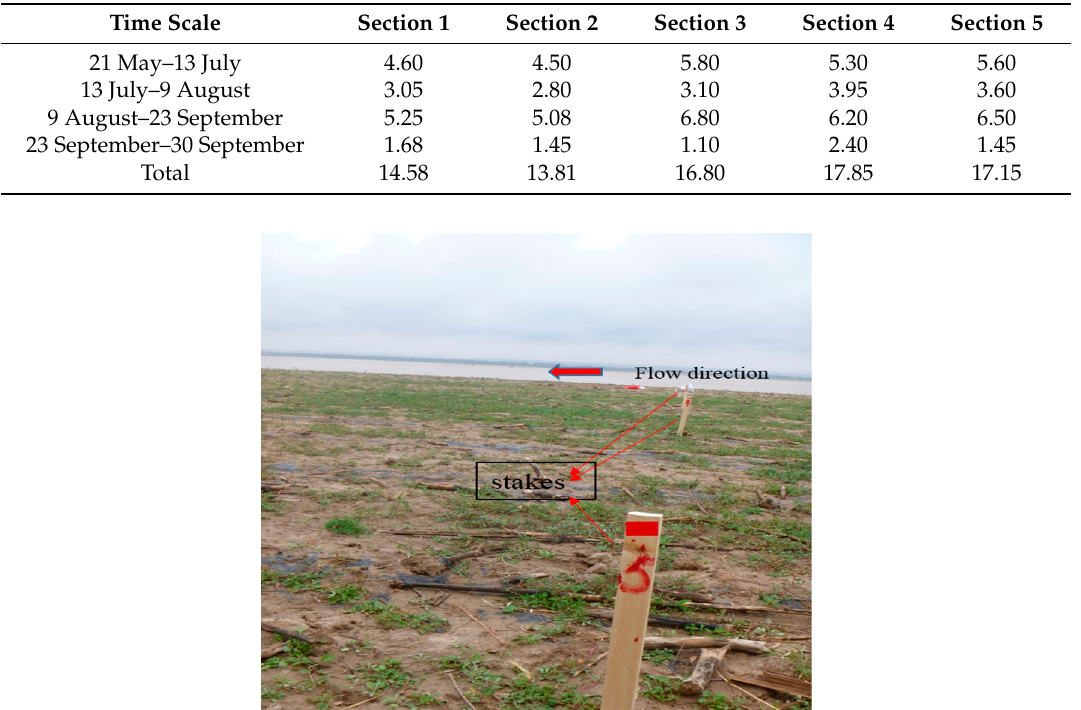
Table 3. Monthly average hydrologic data (2011).